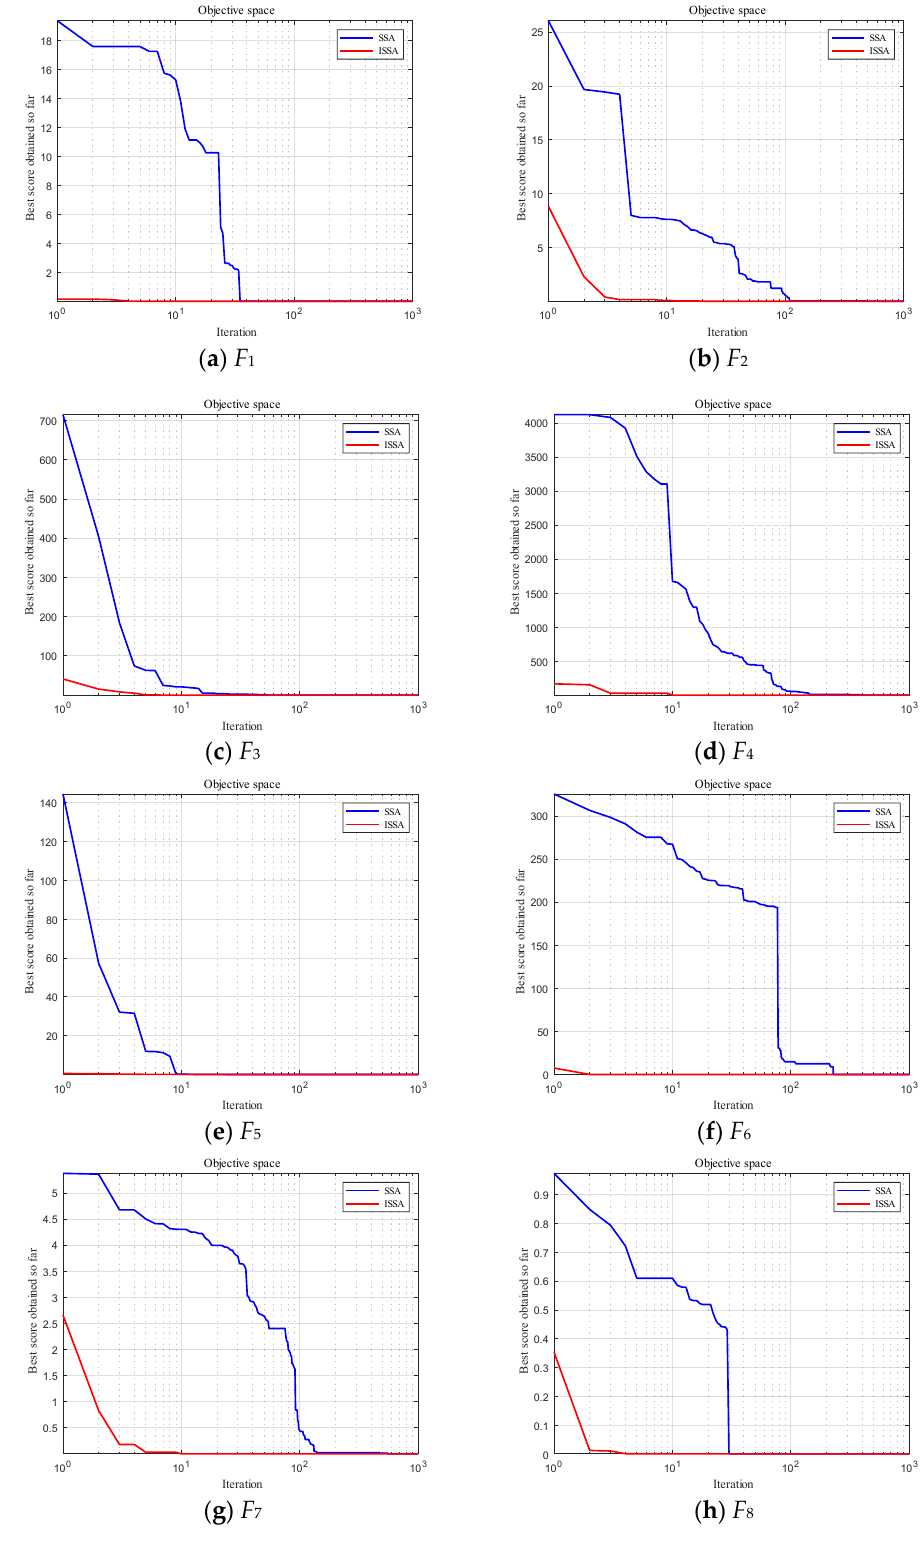
Figure 7. Performance comparison of Sparrow algorithm before and after improvement.